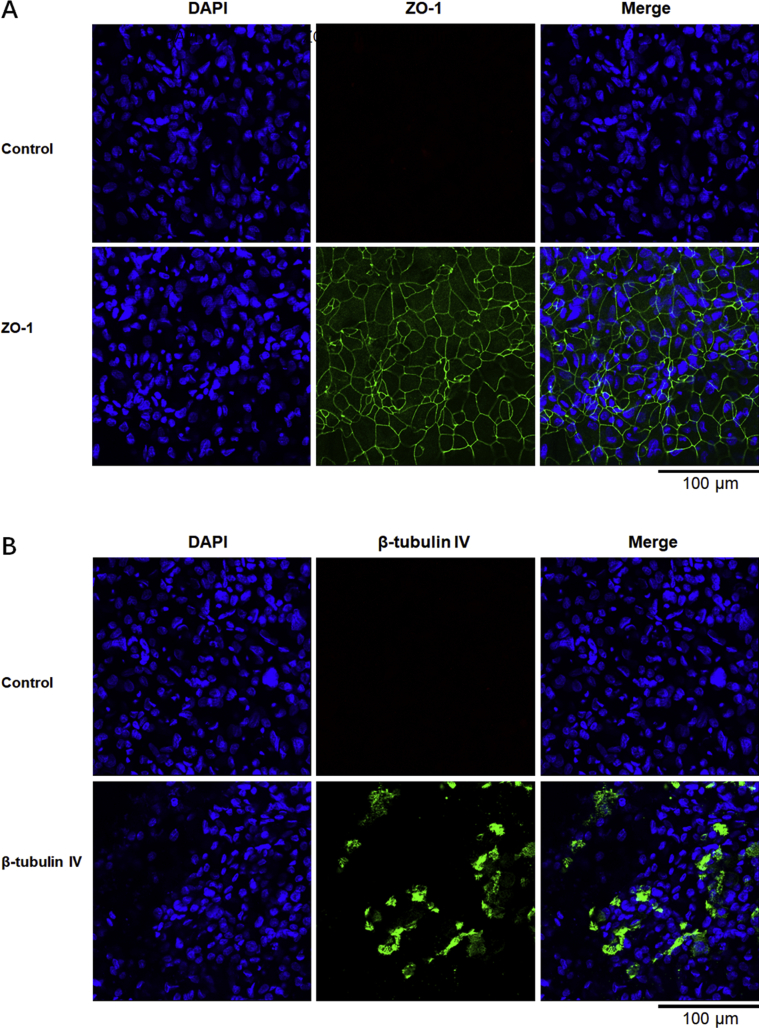
Immunofluorescence analysis of the tight junction marker ZO-1 and the cilia marker β-tubulin IV of well-differentiated normal human primary bronchial/tracheal epithelial cells. Well-differentiated normal human primary bronchial/tracheal epithelial cells were stained with anti-ZO-1 (A) or anti-β-tubulin IV antibody (B). Images were captured using a confocal microscope. Controls were stained with no primary antibody. Nuclei were stained with DAPI (blue).